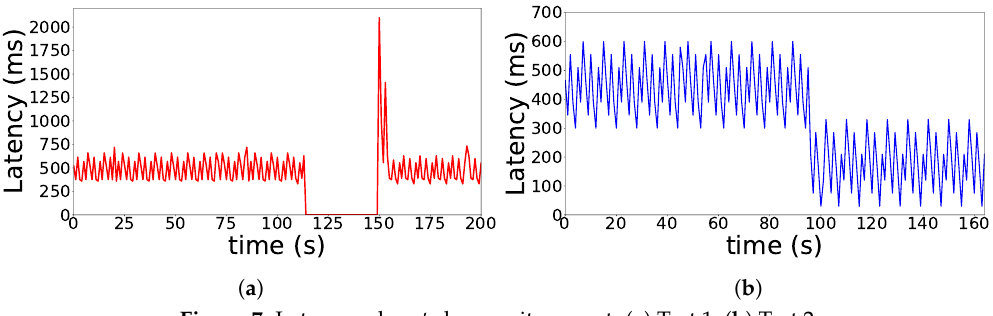
Figure 7. Latency when t changes its parent. ( a ) Test 1; ( b ) Test